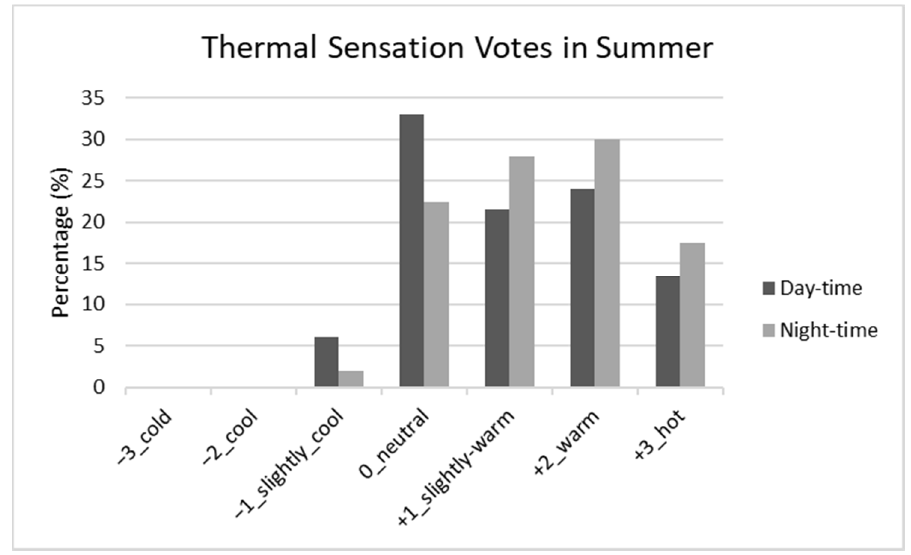
Figure 6. Subjective thermal sensation votes in daytime and night-time in the summer.